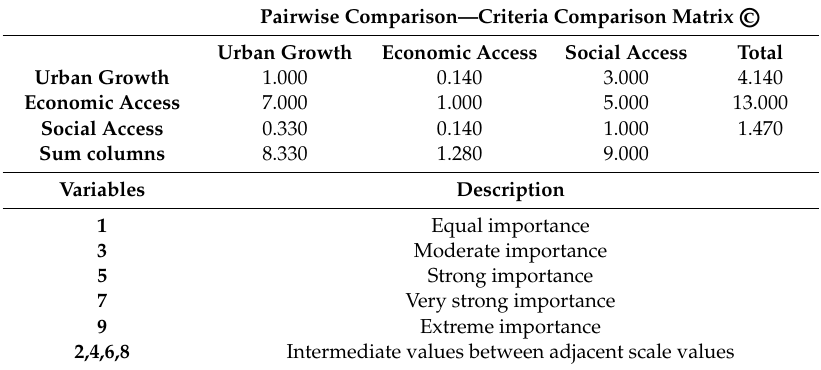
Table 2. Pairwise conditions. Pairwise Comparison—Criteria Comparison Matrix